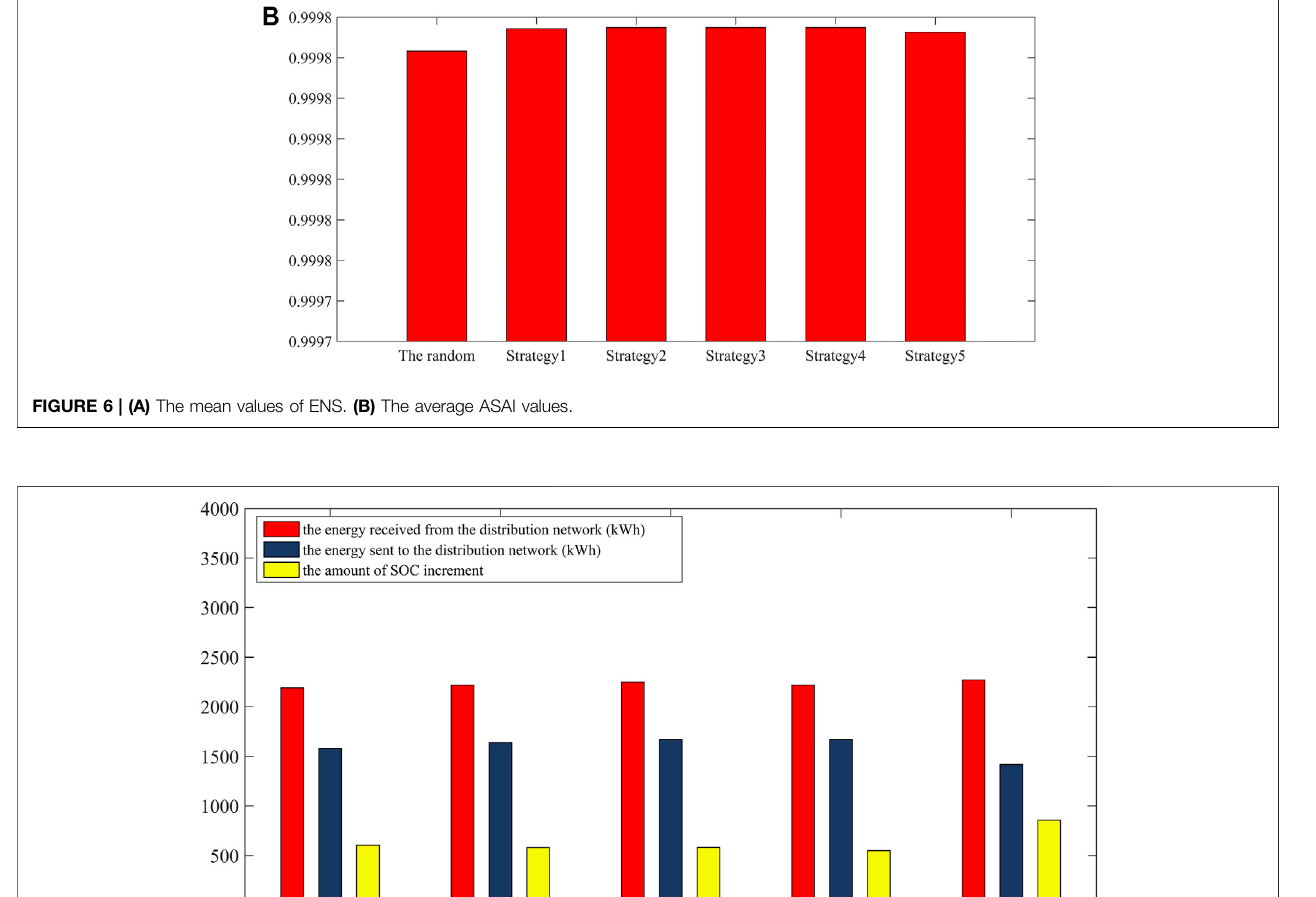
Frontiers in Energy Research |